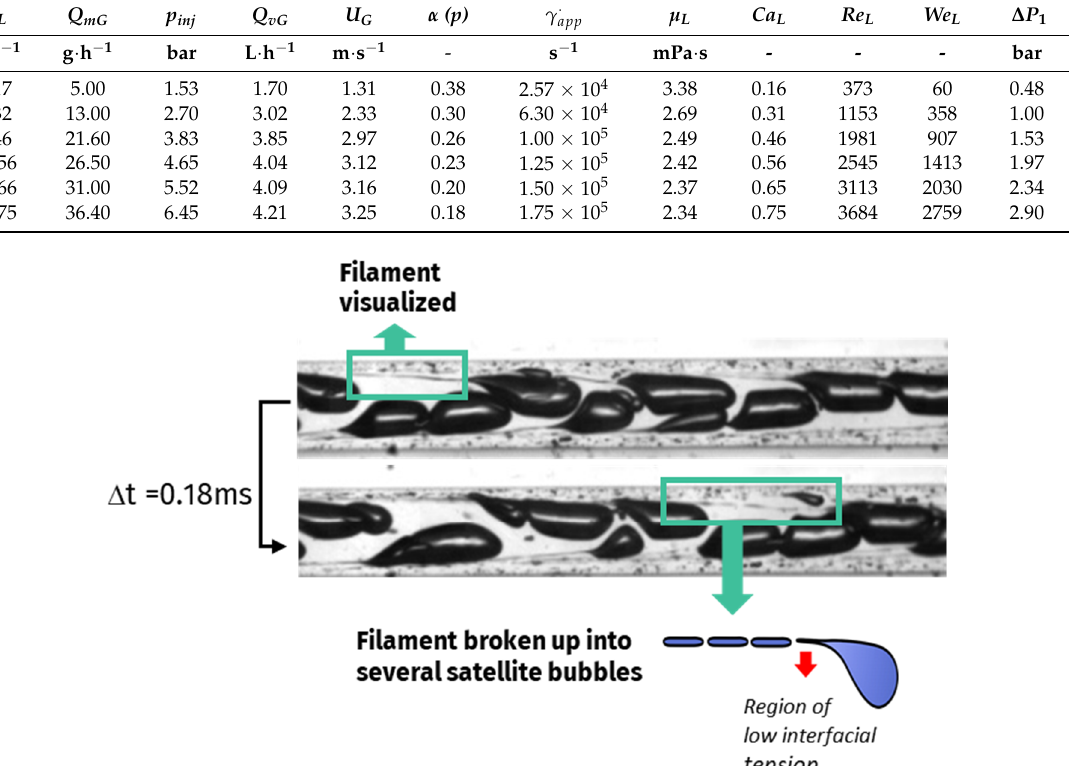
Table 2. Hydrodynamic parameters of the two-phase flow in the mixing channel of the microfluidic device CX600 for several flow conditions using the model solution WPI3XG04.